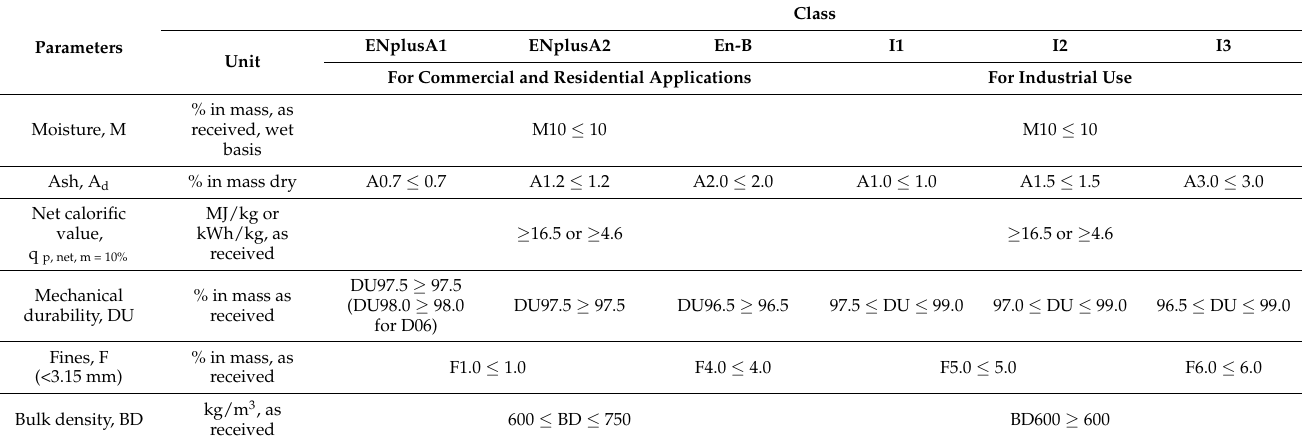
Table 1. Reference specifications for wood pellets according to ENPlus 3 standards (SM EN 17225: